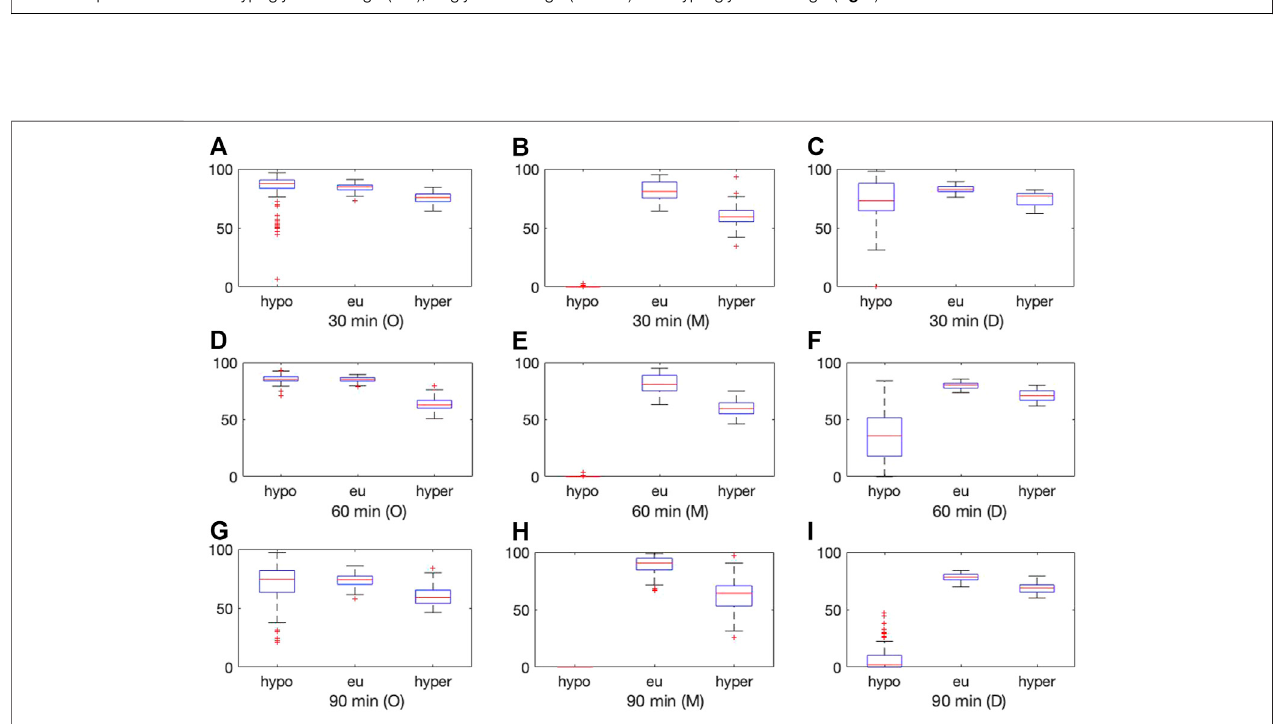
FIGURE6| Boxplotforthe100experimentsconductedwith50%trainingdataforeachpredictionmethod(O (cid:2) ourmethod,M (cid:2) MATLABDeepLearningToolbox, D (cid:2) diffusion geometry approach) with a 30 min ( top ), 60 min ( middle ) and 90 min ( bottom ) prediction horizon and dataset J. Each of the graphs show the percentage accurate predictions in the hypoglycemic range ( left ), euglycemic range ( middle ) and hyperglycemic range ( right ).